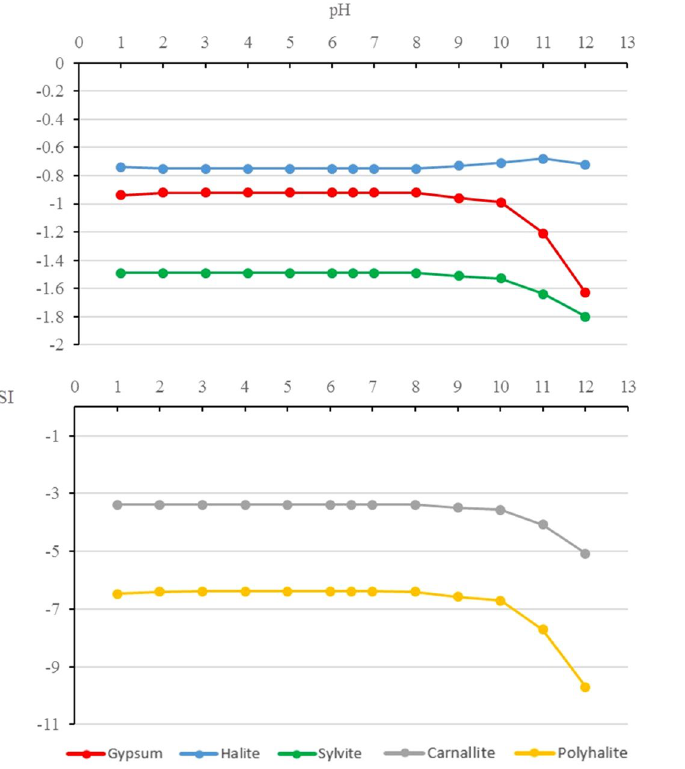
Figure 2. The relationship between SI and